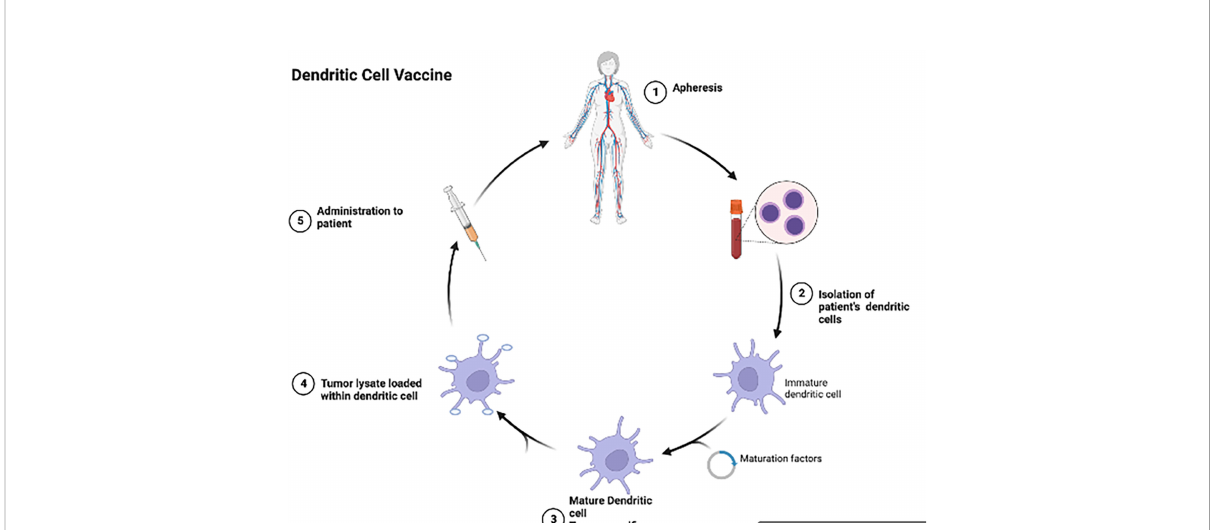
FIGURE 2 Dendritic cells are isolated from the patient ’ s blood, allowed to mature and then tumor lysate is loaded into the dendritic cells and given back to the patient as a